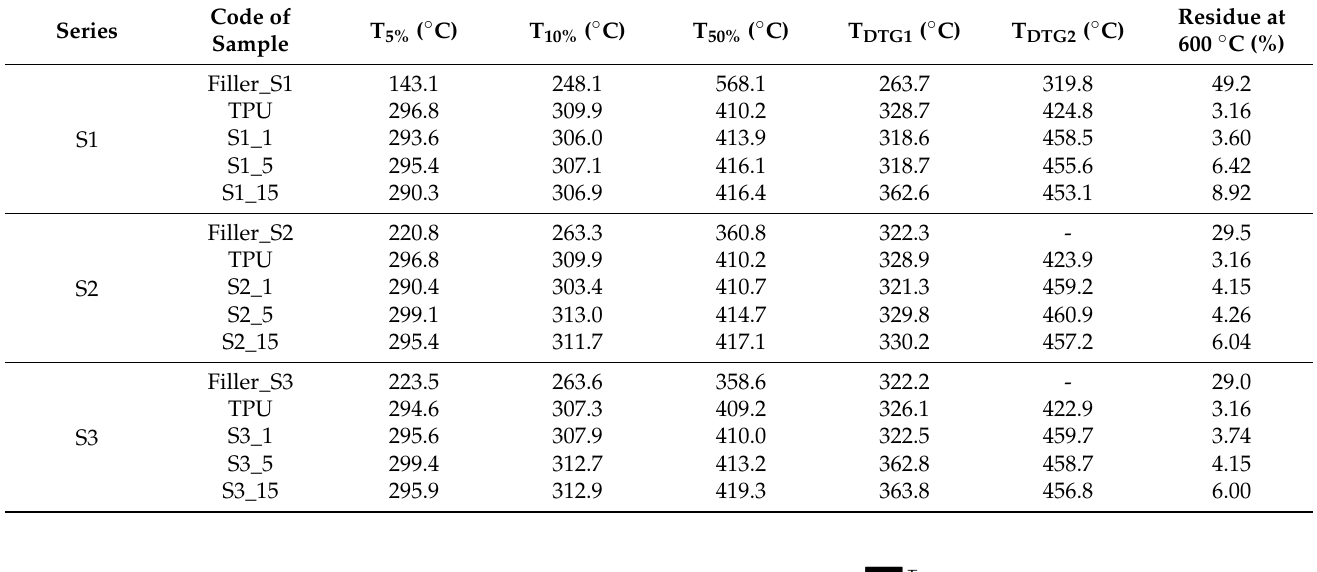
Table 1. Parameters determined from the TG and DTG curves for algae-based fillers, bio-TPU matrices and bio-TPU–ABW composites.